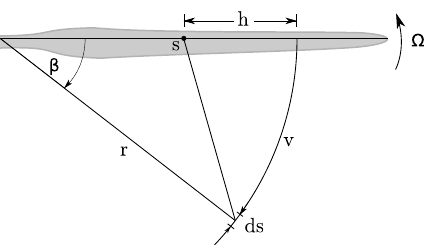
Figure 1. Sketch of the geometry in the near wake. The vortex arc v , trailed at radius r , induces axial (out-of-plane) and tangential (in- plane) velocities at the section s . The radial distance between vortex trailing point and section position is denoted h and h > 0 if the vor- tex is trailed outboard of the section. The angle β describes how far a vortex element with length d s has moved away from the blade. The figure is adapted from Pirrung et al. (2014). In practice, the blade is discretized into many sections and vortices are trailed from the root and tip and in between